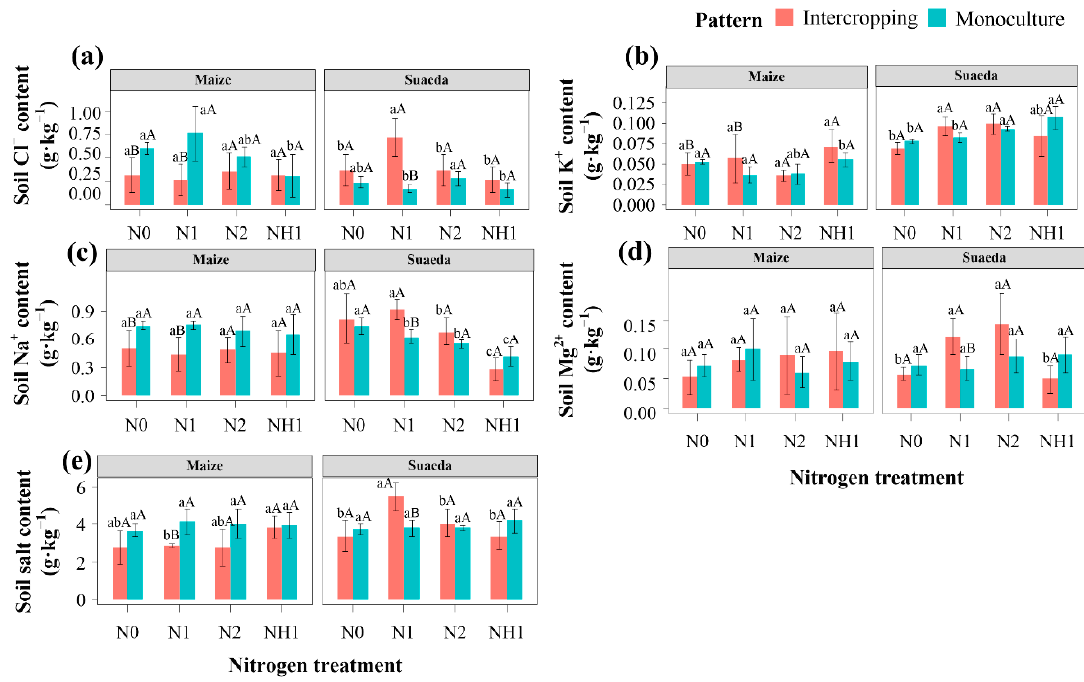
Figure 5. Effects of nitrogen on the content of Cl − ( a ), K + ( b ), Na + ( c ), Mg2 + ( d ), and salt ( e ) in the rhizosphere soil of S. salsa and Z. mays L. in the different cropping patterns. Capital letters indicate the significant differences between two cropping patterns. Lower case letters indicate significant differences of four N treatments.